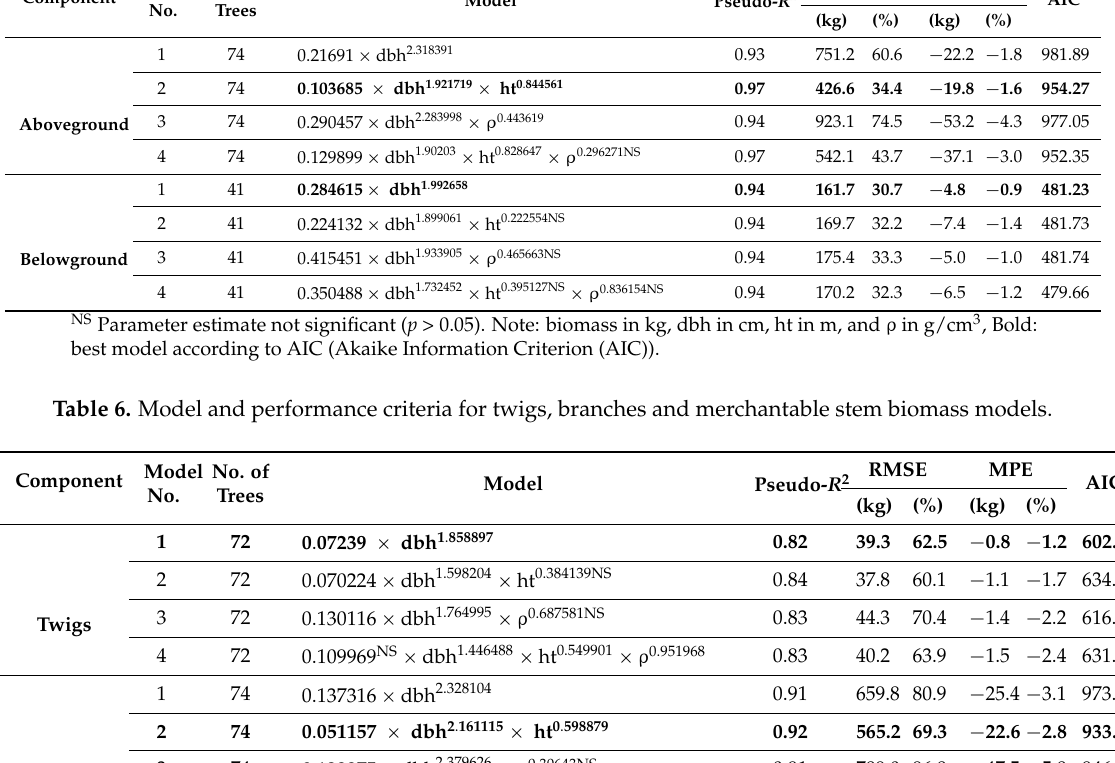
Table 5. Model parameters and performance criteria of above- and belowground biomass models. Component